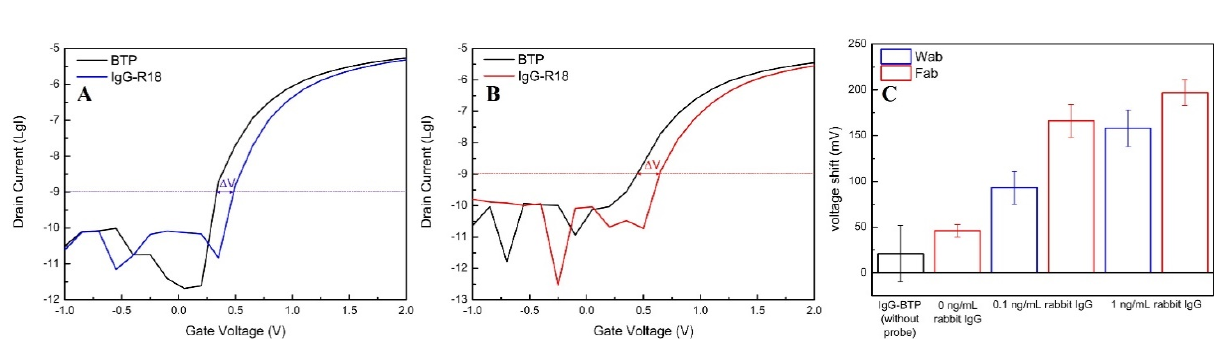
Figure 5. ( A , B ) Representative samples to illustrate the method described in Section 2.6. ( A ) Electrical response of the Wab/APTES-SiNWFETs was initially recorded in 150 mM BTP and plotted as the first curve (the black curve). This im- munosensor was then employed to detect rabbit IgG at 1 ng/mL, followed by incubation with 3 μ g/mL R18 (IgG and R18 were diluted in 150 mM BTP). Finally, its electrical response was measured again and plotted as the blue curve. The signal change generated by formation of the biocomplex (Wab-IgG-R18) was calculated from the formula Δ V = V d1 − V d0 (1), with V d1 as the gate voltage value at I d = 10 − 9 A (LgI = − 9) of the blue curve, whereas V d0 is the gate voltage value at I d = 10 − 9 A (LgI = − 9) of the black curve. ( B ) Electrical response of the Fab/APTES-SiNWFET was initially recorded in 150 mM BTP and plotted as the first curve (the black curve). This immunosensor was then employed to detect rabbit IgG at 1 ng/mL following by incubation with 3 μ g/mL R18 (IgG and R18 were all diluted in 150 mM BTP). Finally, its electrical response was measured again and plotted as the blue curve. The signal change generated by formation of the biocomplex (Fab-IgG-R18) was calculated from the formula ∆ V = V d1 − V d0 (1), with V d1 is the gate voltage value at